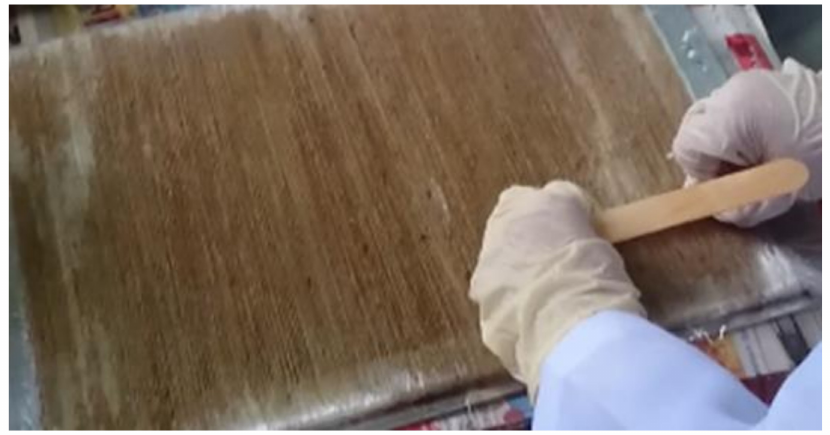
Figure 3. The example of a unidirectional kenaf fiber reinforced polymer (KFRP) composite sample after the curing